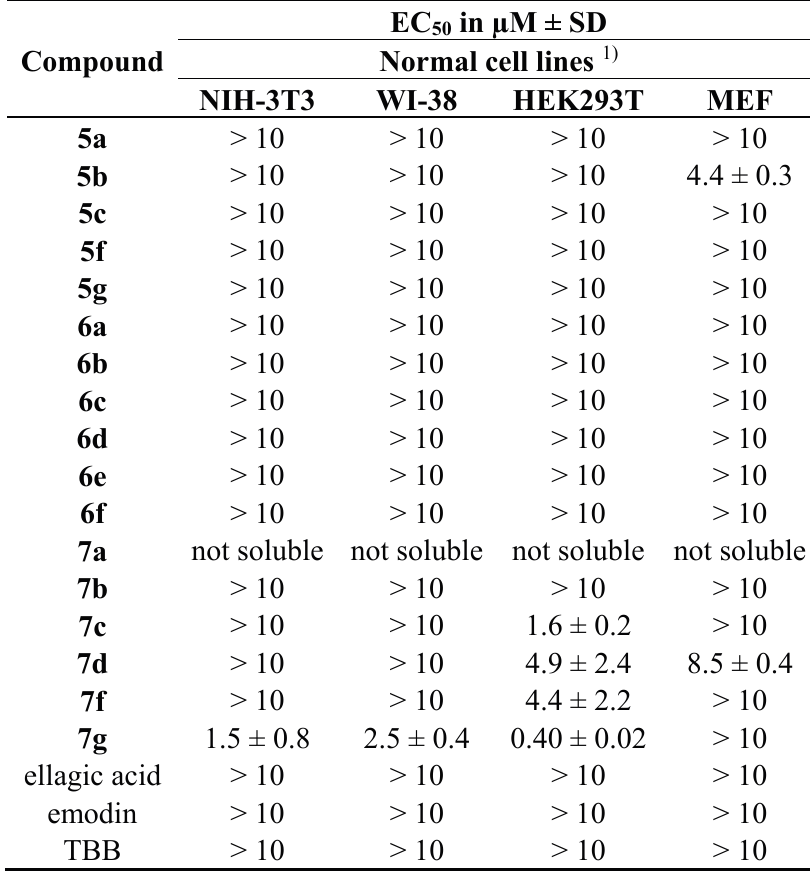
Table 2. EC 50 values of selected compounds 5 – 7 and TBB against four cell